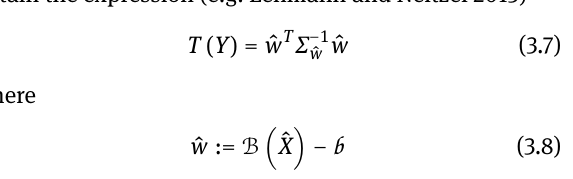
Figure 1: Probability density functions f of test statistic T under H 0 and H A and decision errors α , β